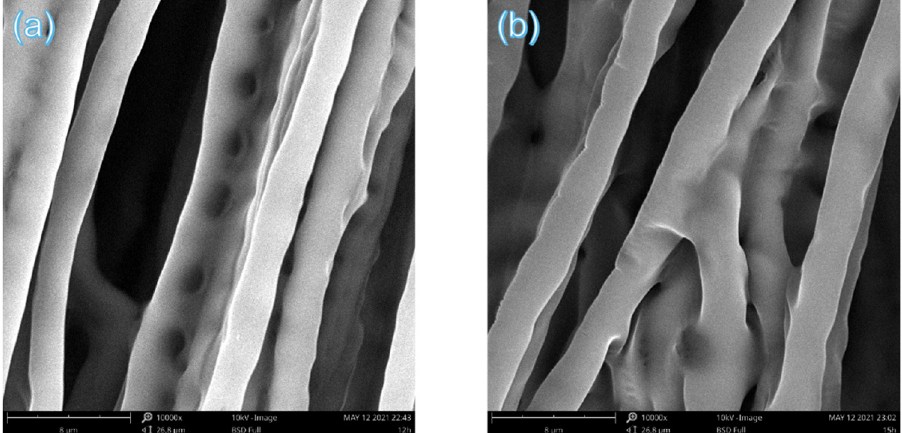
Figure A2: SEM of di ff erent elution time: 12 h ( a ) and 15 h ( b ) .